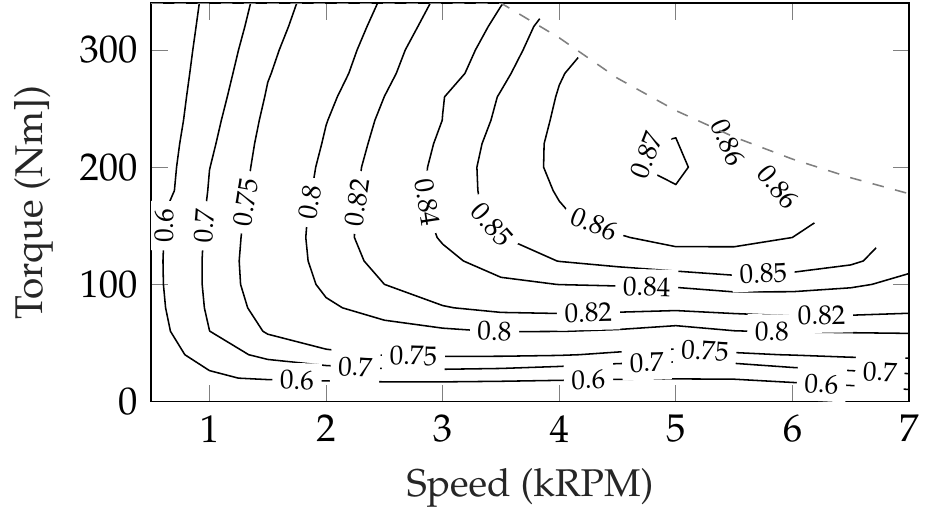
Figure 5. Measured DC/DC efficiency of the energy transfer system shown in Figure 2.